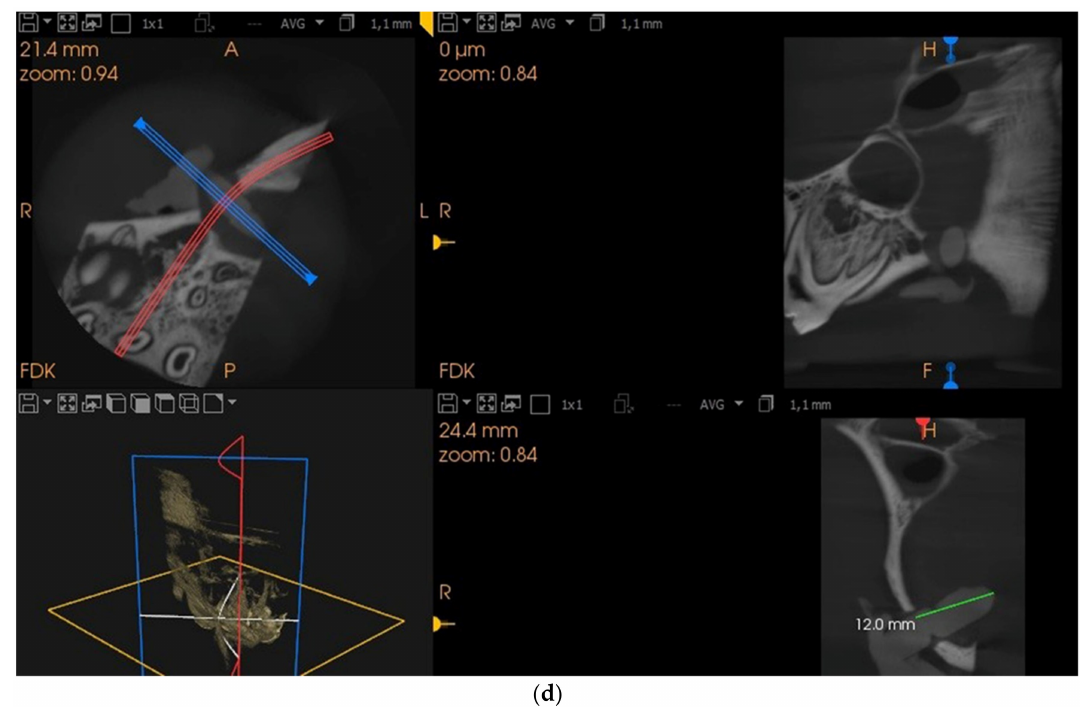
Figure 1. ( a ) New lifting device invented by the author. From left to right. Insertion of the device into the sinus, beginning of inflation, maximum pressure and inflation, deflation of the balloon after eleva- tion. ( b ) Elevation window. ( c ) Section for histological analysis. ( d ) CBCT scans, 5 × 5. Oblique